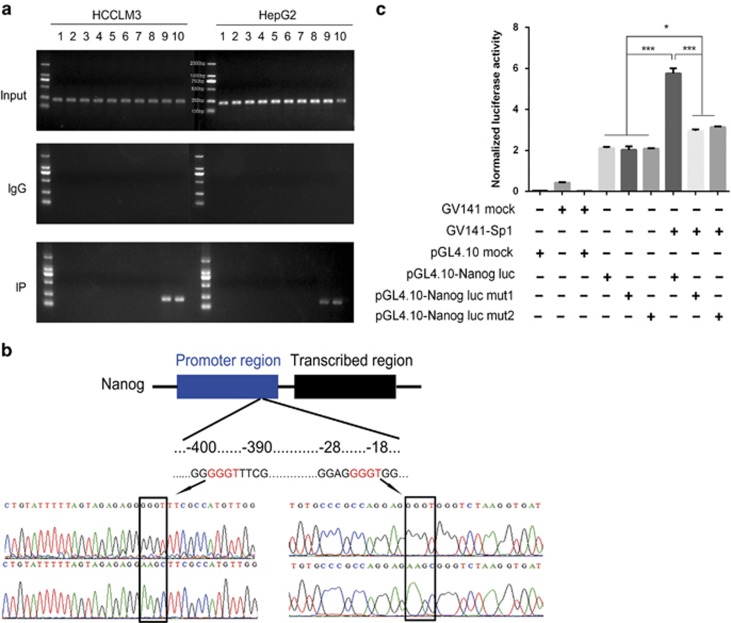
Sp1 binds to the promoter of Nanog. (a) Chromatin immunoprecipitation in both HepG2 and HCCLM3 cell lines. (b) Schematic diagram of the dual luciferase protein target reporter vector with wild type (upper panel) or mutant (lower panel) of Nanog and confirmed by DNA sequencing. (c) Luciferase activity was assayed in miR-612-o HCCLM3 cells. Data are mean±S.D. (n=3) and are representative of three independent experiments